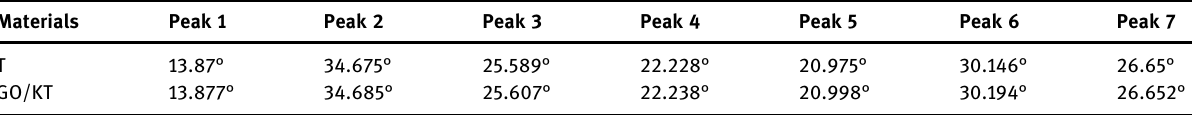
Table 7: Change of peak line position before and after modi fi cation of tourmaline Materials